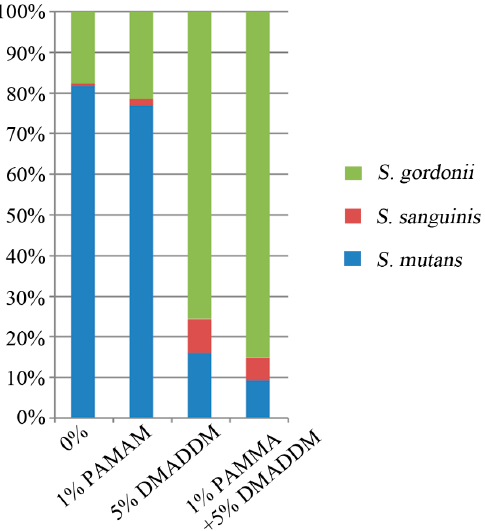
Figure 5. The ratios of S. mutans , S. sanguinis , and S. gordonii in three-species biofilms, conducted by TaqMan real-time polymerase chain reaction.